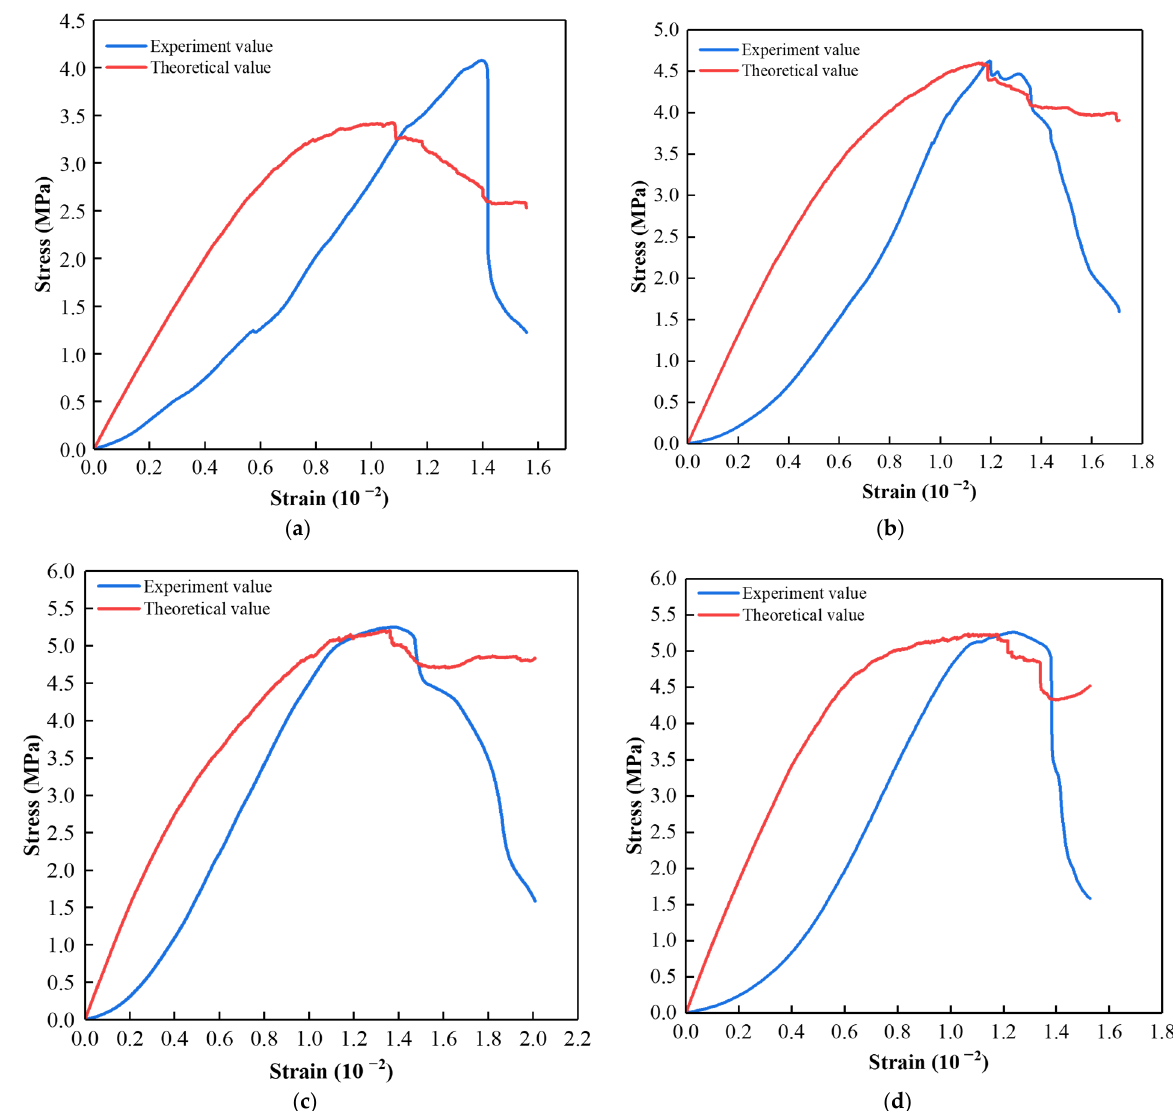
Figure 12. Comparison of Experiment value and Theoretical value of σ and ε . ( a ) 0.002; ( b ) 0.005; ( c ) 0.0075; ( d ) 0.01.